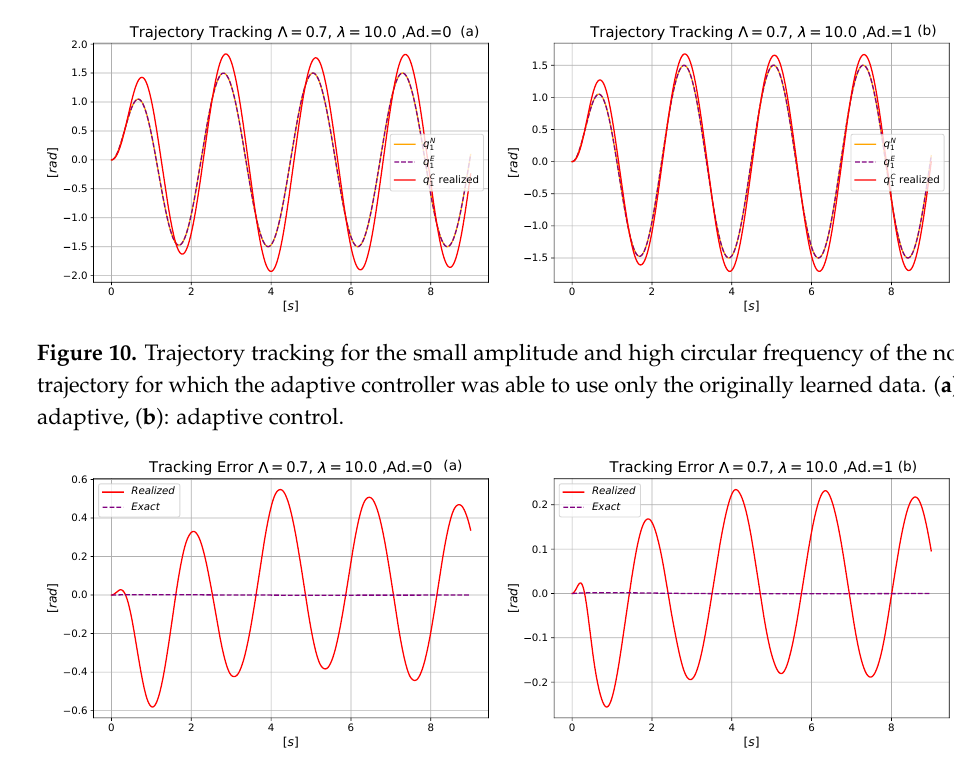
Figure 11. Trajectory tracking error for the small amplitude and high circular frequency of the nominal trajectory for which the adaptive controller was able to use only the originally learned